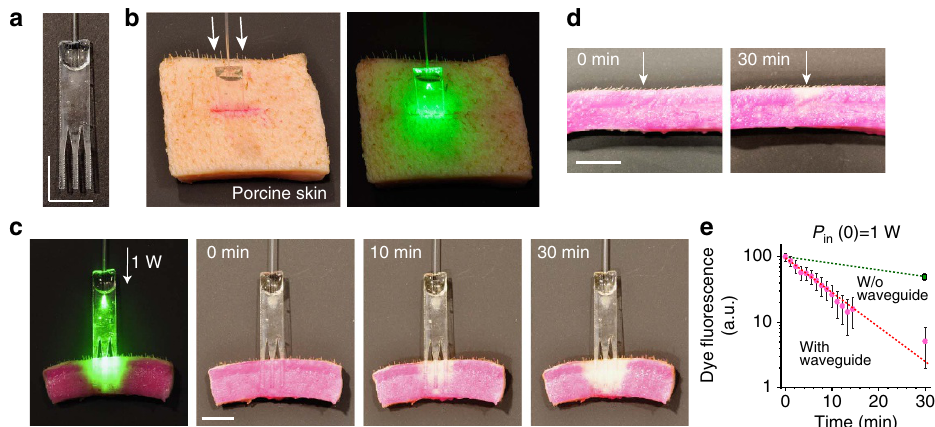
Figure 4 | Light delivery to deep tissue. ( a ) Hybrid biopolymer-based waveguide bundle engineered for optimal light delivery to the tissue. ( b ) Waveguide inserted in porcine skin incision previously stained with Rose Bengal dye (left) and illuminated through a fibre by a green laser (right). ( c ) Cross-section of the photoactivated area of dyed porcine skin after different times of illumination using a biopolymer-based waveguide bundle. The presence of photobleaching down the entire depth of the tissue interface after 30min of illumination indicates efficient light delivery throughout the entire depth of the sample. ( d ) Identical porcine skin sample treated with surface illumination (that is, without (w/o) using a waveguide). Note that even after 30min of continuous illumination, only the dye close to the top surface has bleached. ( e ) The amount of remaining intact dye measured by red fluorescence (averaged over whole area of the waveguide, N ¼ 1) decreases exponentially with time. The error bars represent s.d. across the area. Scale bars, 10mm in a , c and d .